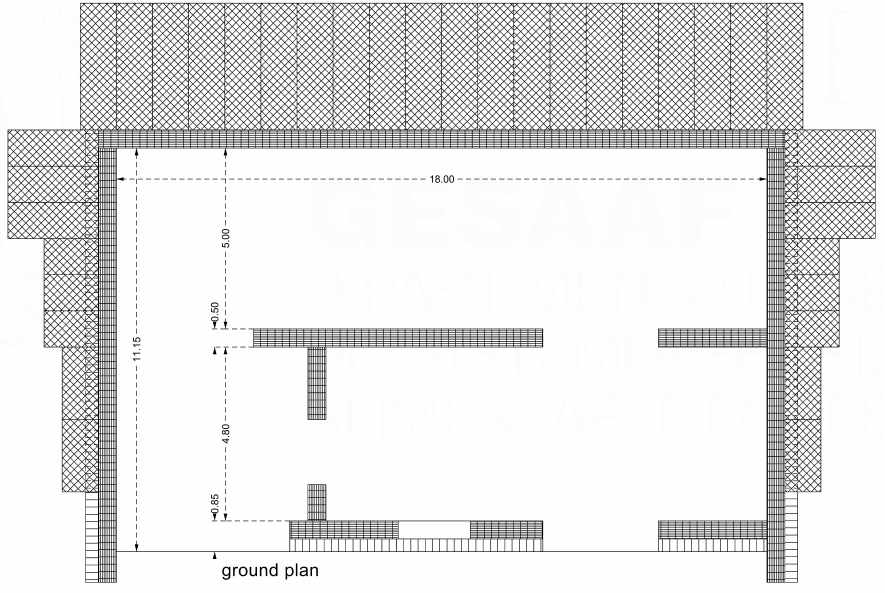
Figure 1. The building’s ground